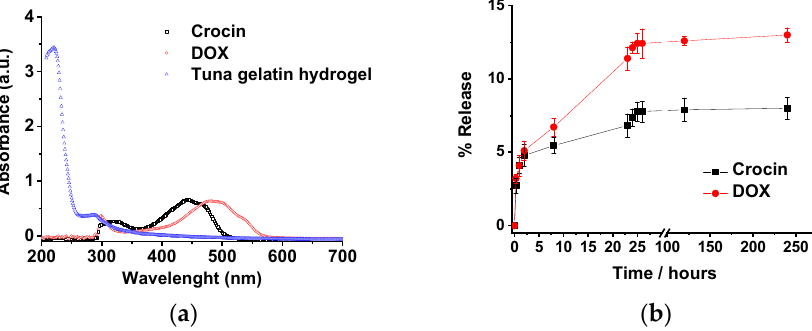
Figure 18. ( a ) UV-Vis spectra of non-loaded tuna gelatin hydrogel, Crocin and Doxorubicin in milli-Q water. ( b ) Release profiles of Crocin and DOX from loaded-gelatin at a different time in PBS pH 7.4 at 30 ◦ C. The drug releases were tested in three replicates. Error bars are 2 σ